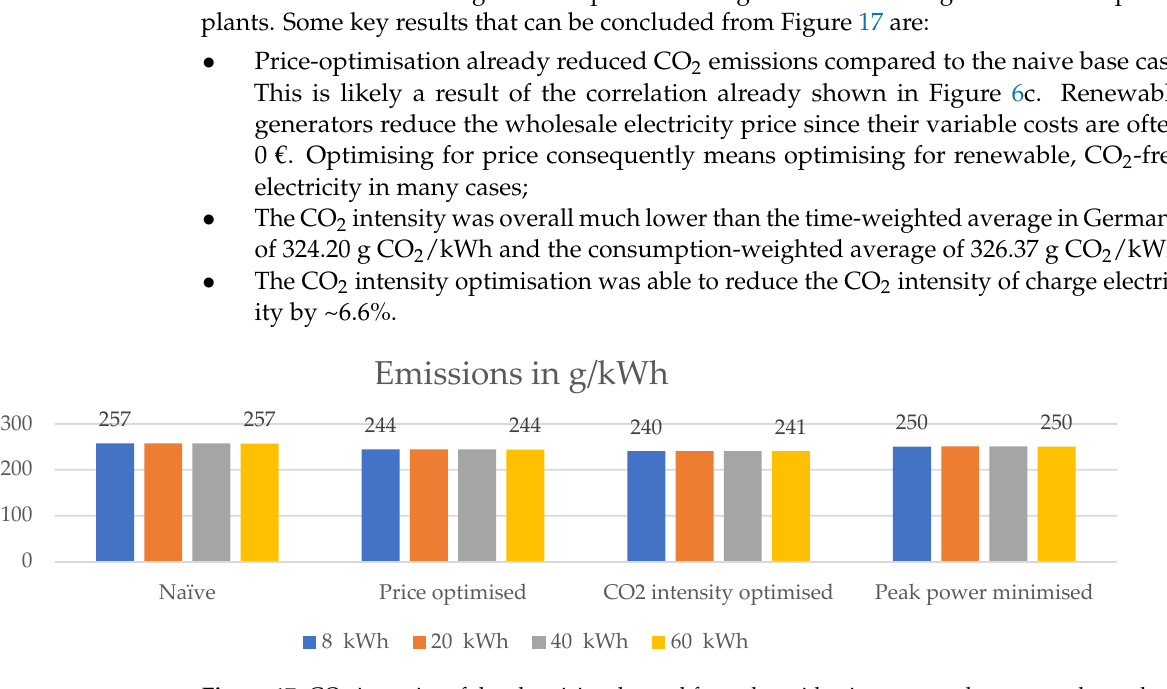
Figure 17. CO 2 intensity of the electricity charged from the grid using assumed energy recharged per charge event and charging strategies.